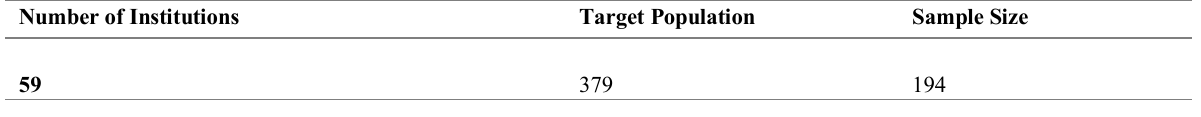
Table 1: Target Population